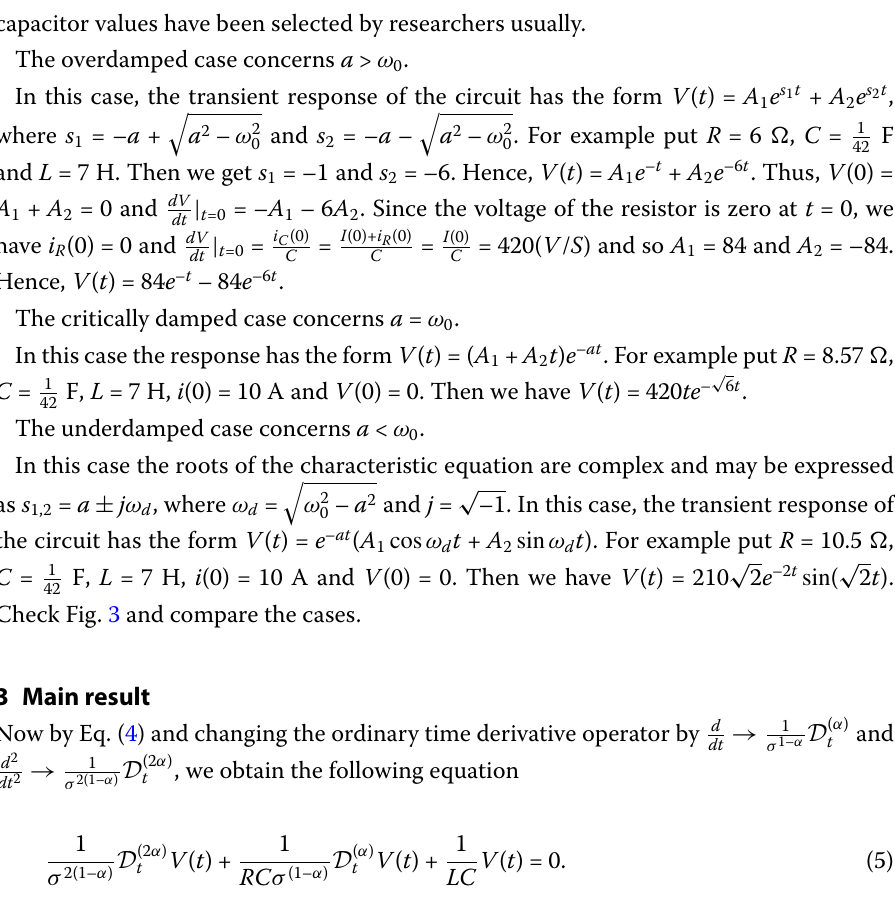
and ω 0 = 1 √ . 2 RC LC